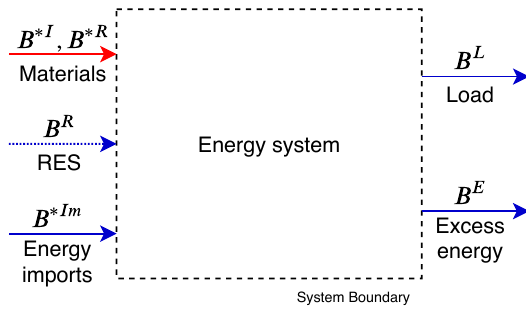
Figure 1. Material, RES, energy imports, load and excess energy flows over the system boundaries in an energy systems (source: own